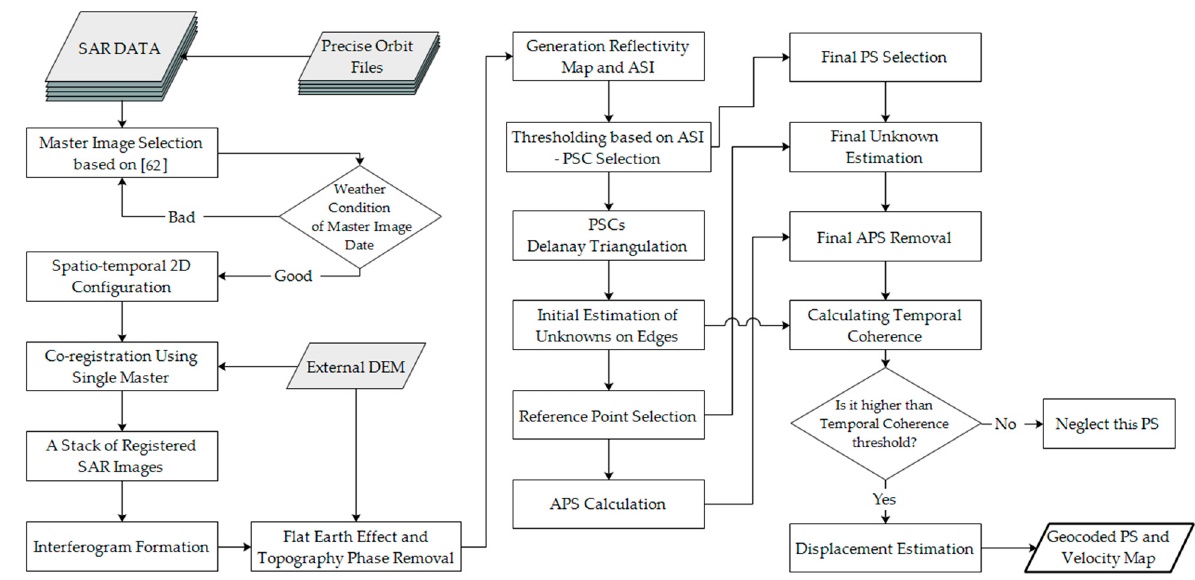
Figure 2. Workflow of PSI processing in SARPROZ based on [64].